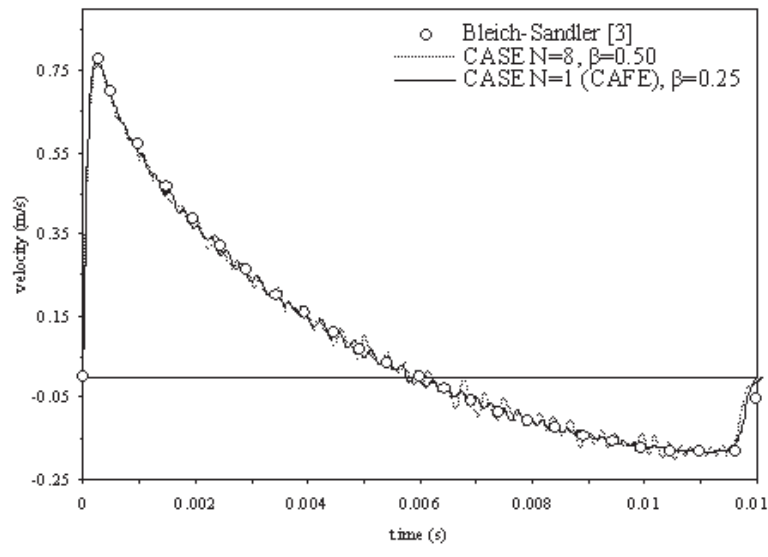
Fig. 18. Comparison of the velocity of m 1 for the Bleich-Sandler problem using CAFE with β = 0.25 and 8th order CASE with β = 0.50. identical to the 8th order CASE and FE-FCT results. This is demonstrated in Fig. 18, which compares the β = 0.50 8th order CASE result to the β = 0.25 CAFE result. From this result we see that in the Bleich-Sandler problem it is possible to obtain results with a CAFE model that match higher order CASE results and do not exhibit as many oscillations simply by reducing the value of β in the CAFE